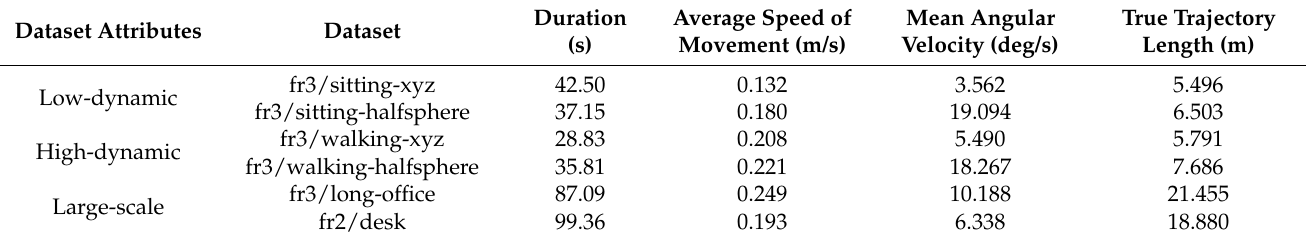
Table 2. The parameters of TUM dataset.